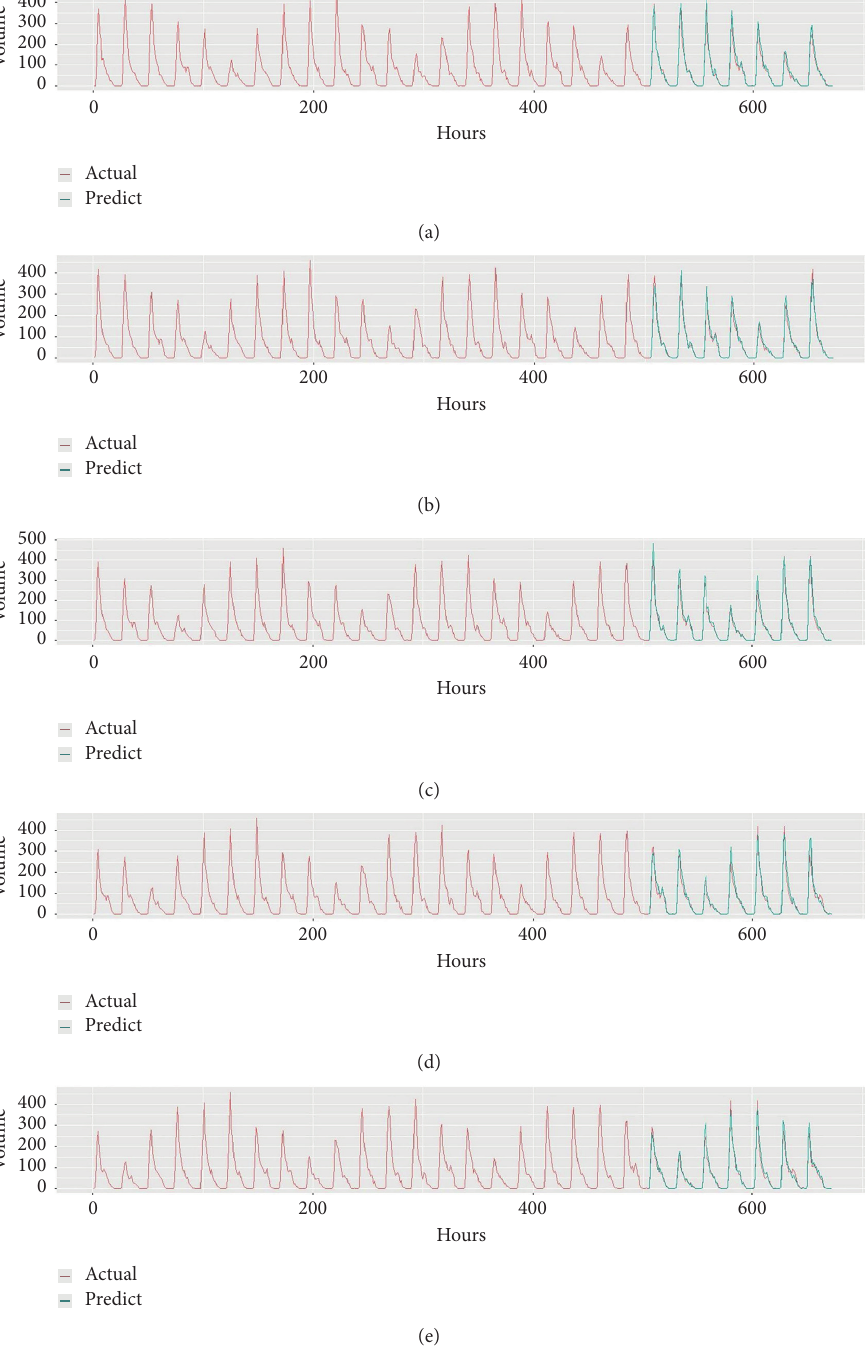
Figure 9: Forecast results of the parking duration category D3 of each slice. (a) D3, slice 2, and MRE: 16.91%. (b) D3, slice 3, and MRE: 13.06%. (c) D3, slice 4, and MRE: 13.49%. (d) D3, slice 5, and MRE: 17.26%. (e) D3, slice 6, and MRE: